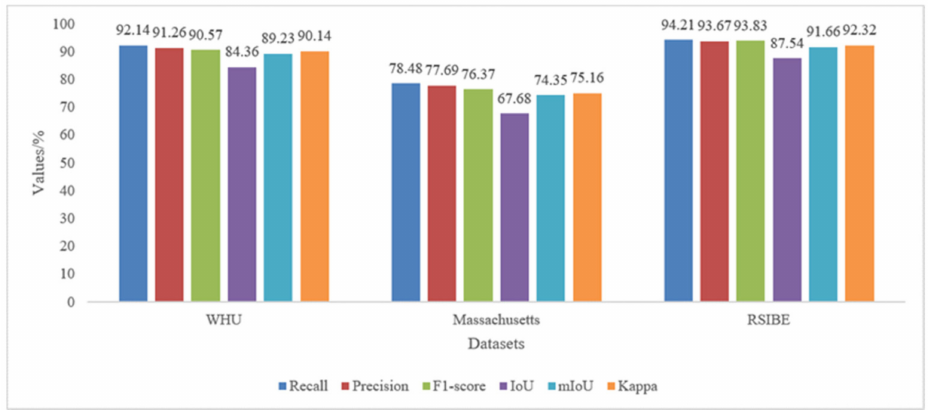
Figure 15. Accuracy of building edge extraction on the experimental